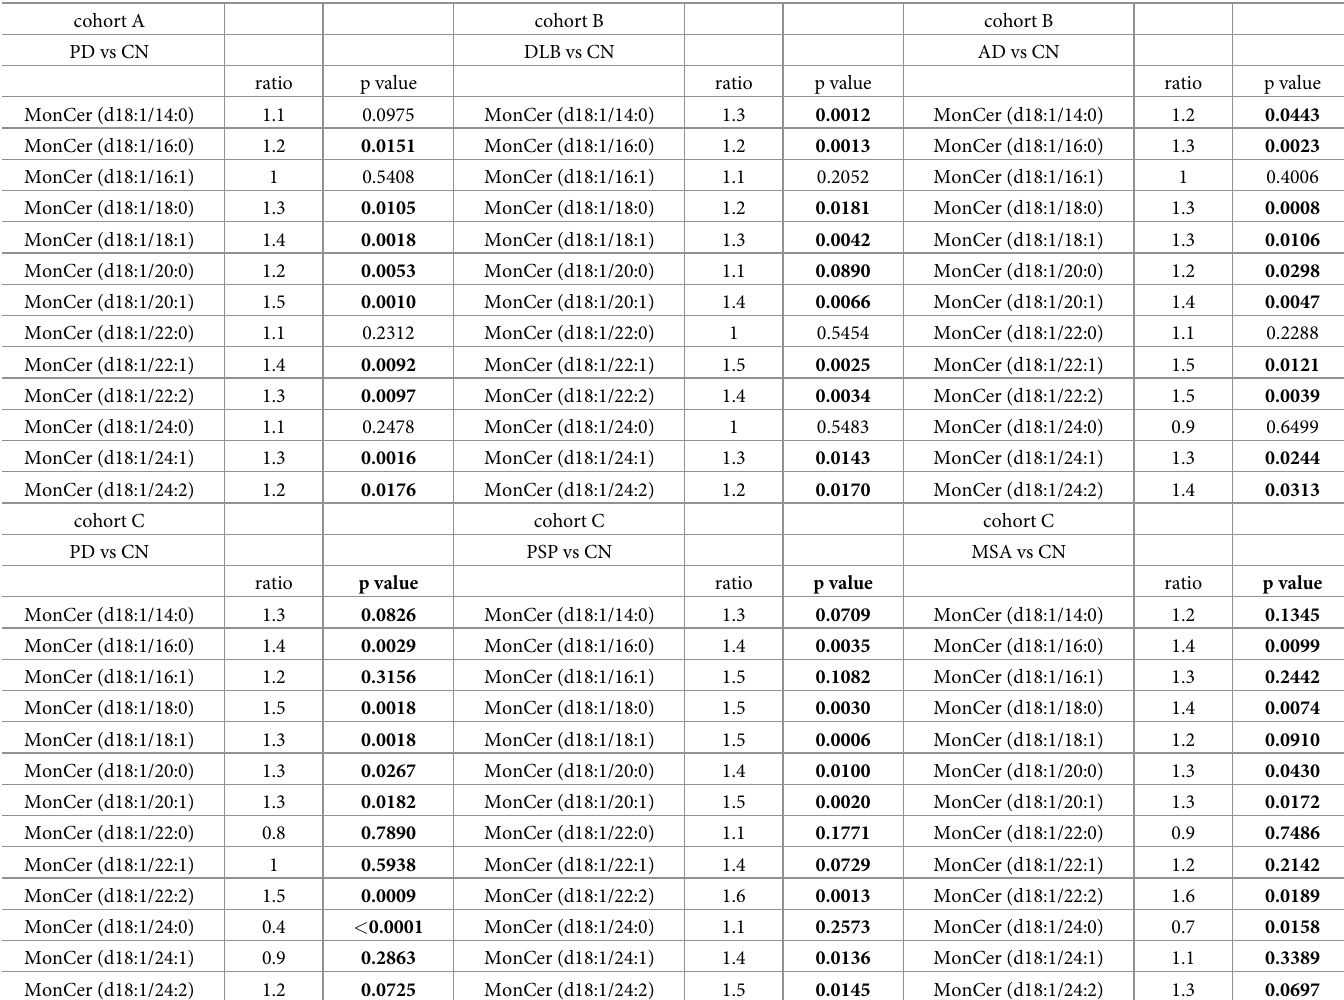
Table 2. Plasma all MonCer levels in neurodegenerative